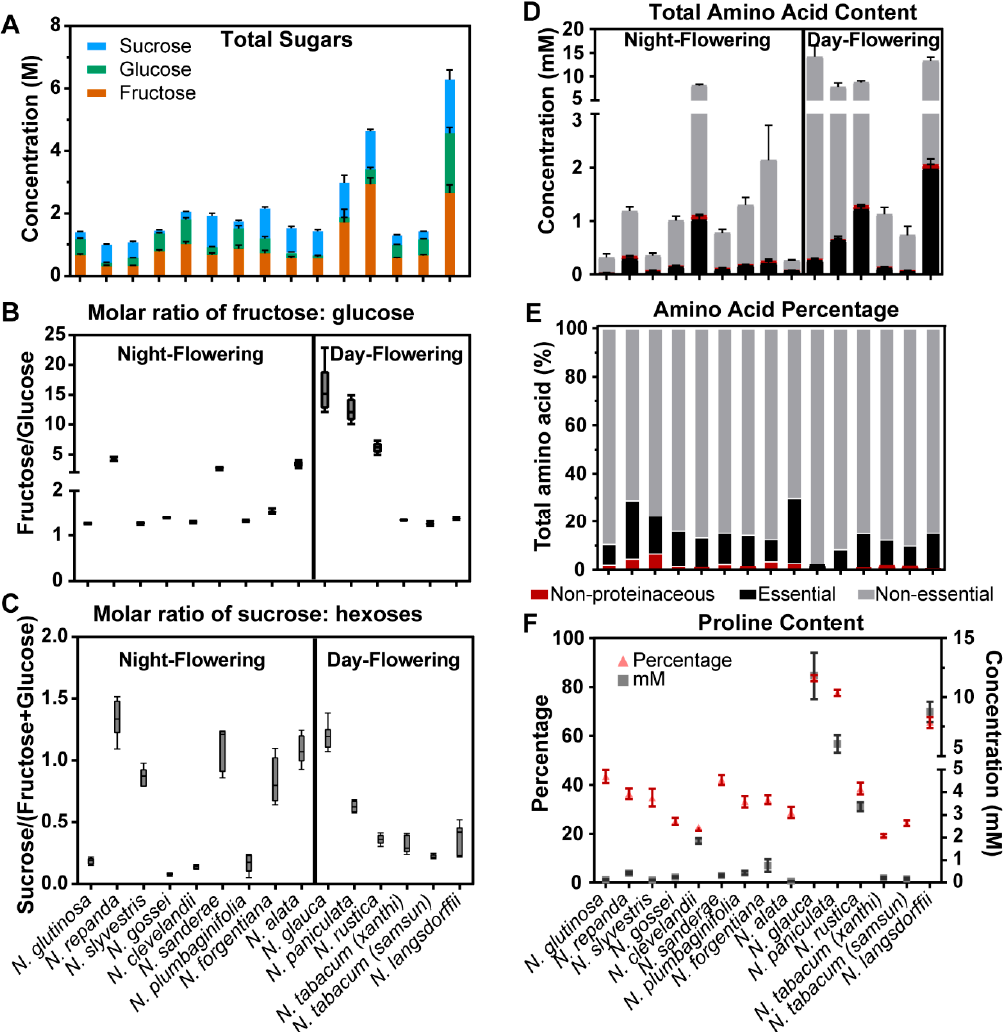
Figure 2. Sugar and amino acid profiles among the fifteen Nicotiana species. ( A ) Sum of total sugar content highlighting the contributions of each of the three main sugars, sucrose, glucose and fructose. ( B ) Molar ratio of fructose to glucose. ( C ) Molar ratio of sucrose to the total hexose content. ( D ) Sum of total amino acid content highlighting the contributions of nonproteinaceous, essential, and nonessential amino acid categories. ( E ) Proportion of nonproteinaceous, essential, and nonessential amino acid categories. ( F ) Percentage and concentration (mM) of proline in each nectar. Error bars represent the standard error, from 6 replicates.